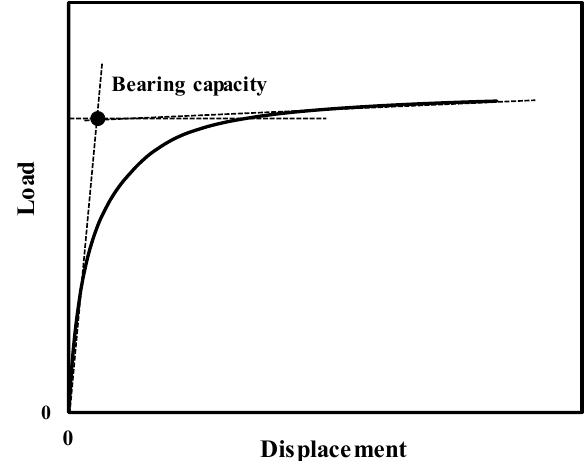
Figure 4. Tangent intersection method for determining carrying capacity.